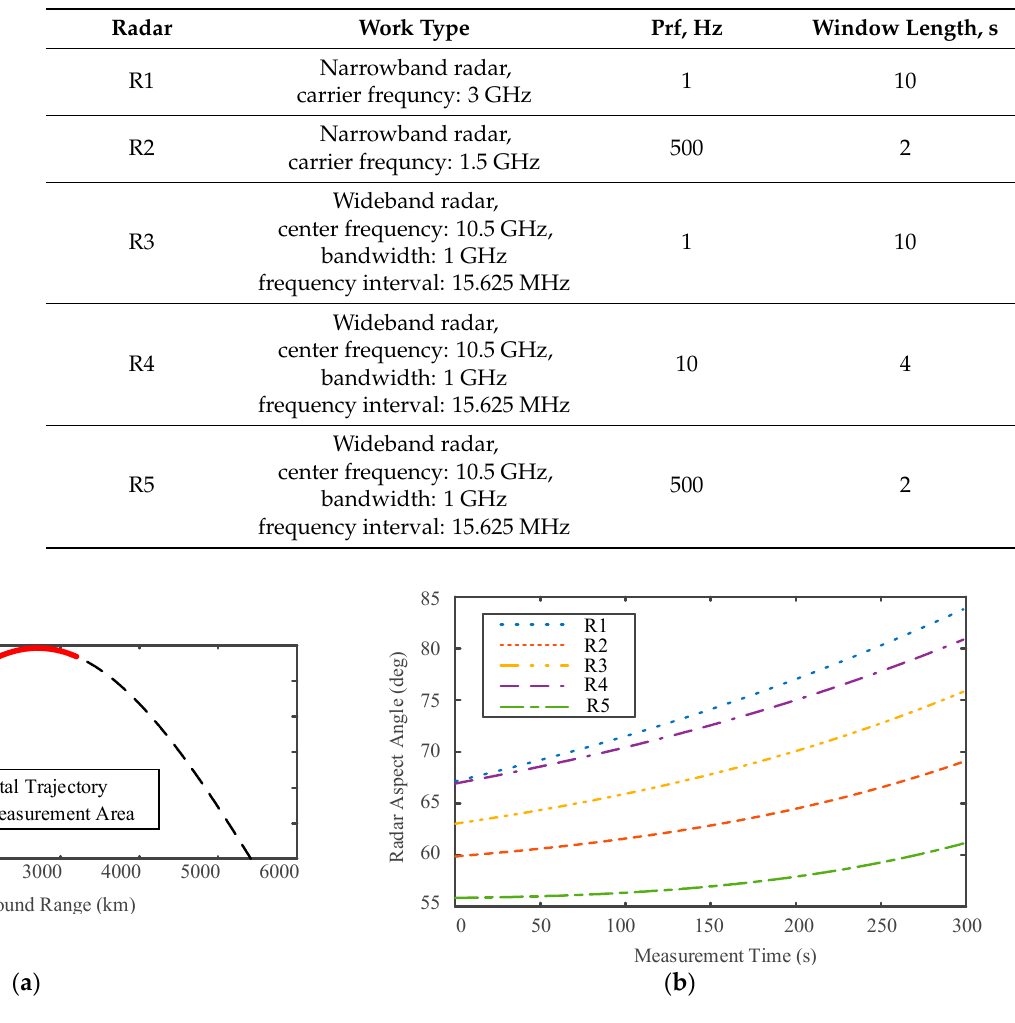
Table 1. Ground-based radar net parameters.